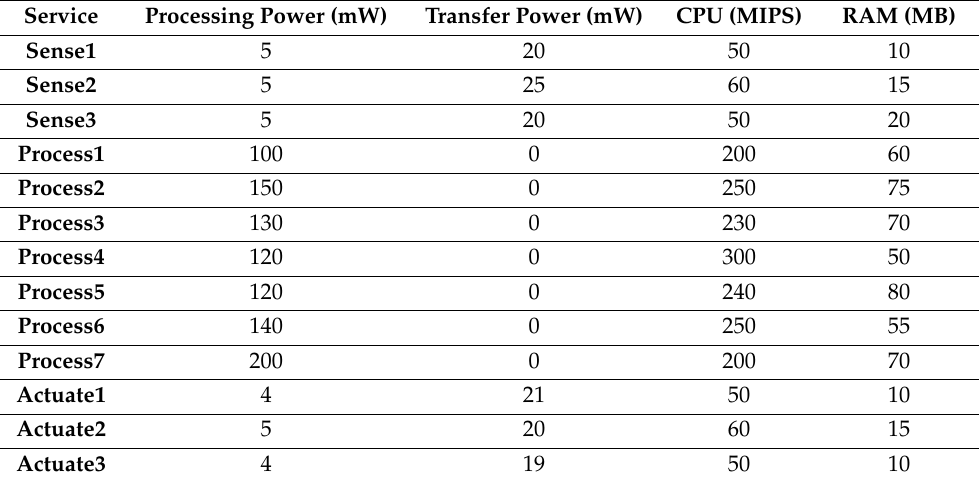
Table 3. Resources required by the